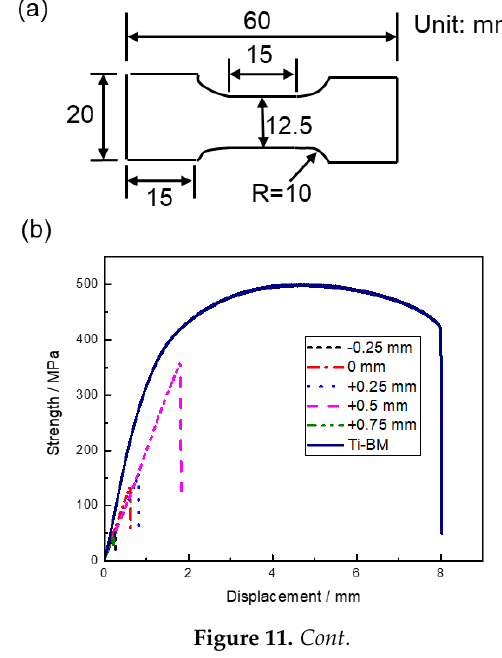
Figure 11. The shape and sizes of tensile specimens ( a ) and results of tensile tests: ( b ) tensile test results of Mo/Ti joints and the BM of titanium, ( c ) variation of average tensile strength of Mo/Ti joint against laser beam offset. Table 2 Tensile result of a group of welded joints and BMs.